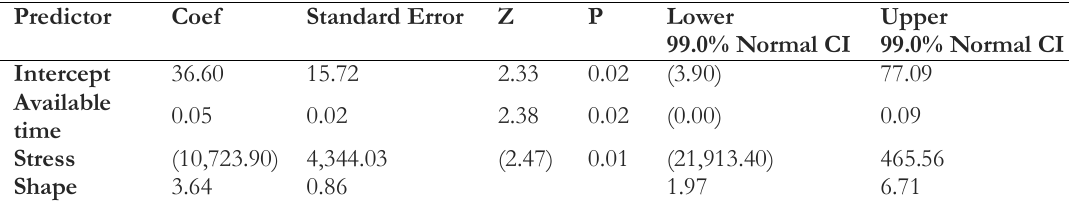
Table 6. Regression table.